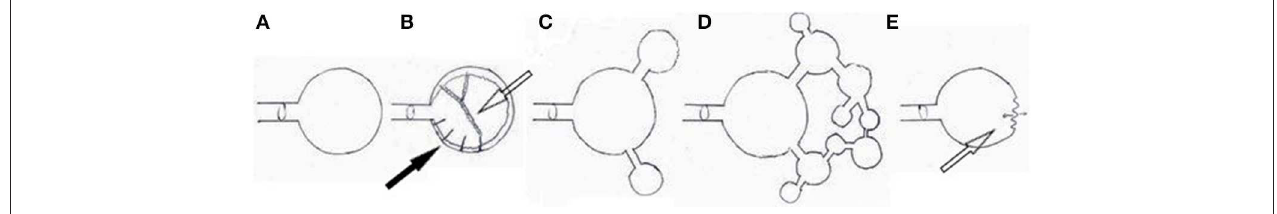
FIGURE 8 | Theoretical models. (A) simple Helmholtz resonator; (B) “resonator with variable absorbing lining material:” damping by mucous membranes, mucosal folds hanging across the tympanic cavity (hollow arrow), and baffle-like open hypotympanic cells on the tympanic cavity floor (black arrow); (C) “combination of multiple resonators:” simplified concept in which the attic, mastoid, and temporal apex, act as extra resonators that absorb specific frequencies from the main resonator; (D) “resonator tree:” more realistic concept, in which a multitude of small air cells (small resonators) ultimately alters the damping properties of the whole system in a complex way; (E) “Compliant Backplate Helmholtz Resonator:” resonance of the system is modified by the stiffness properties of the TM (hollow arrow), that transmits part of the energy outside the